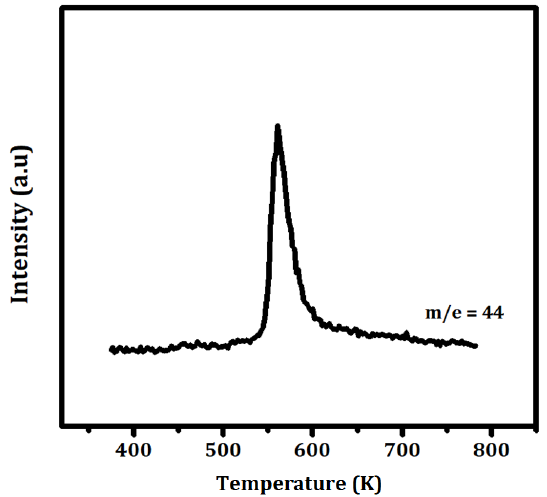
Figure 5. Temperature-programmed oxidation performed on the ZrO 2 after exposure to the Ce(TMHD) 4 precursor. The heating rate for the sample was 20 K/min.